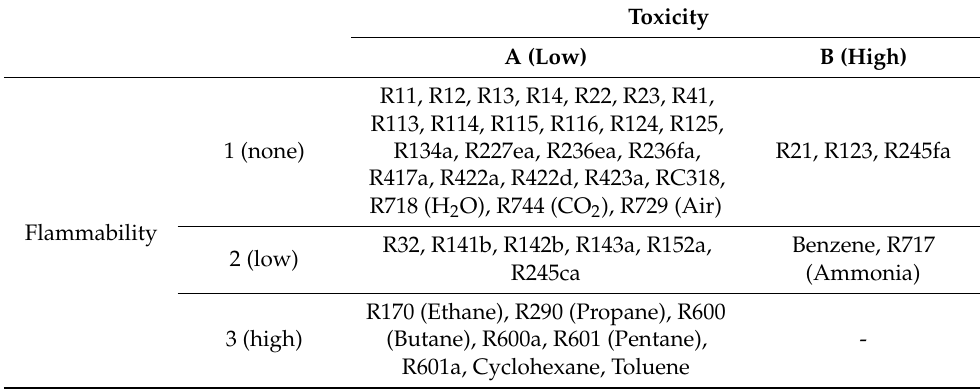
Table 3. Safety groups of working fluids.